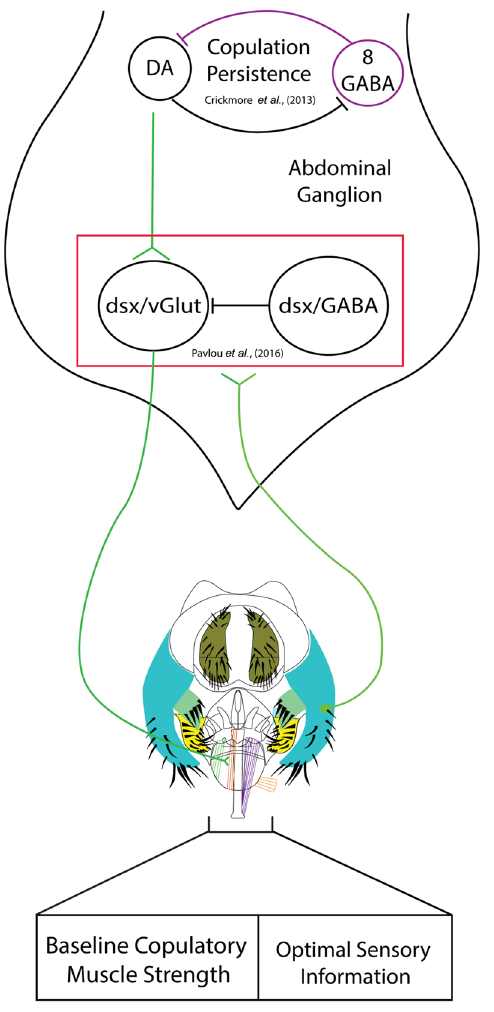
Figure 5. Proposed model of how sensory information from the MSNs is incorporated into the neural circuit that governs copulation persistence. Genital coupling requires the activation of the dsx /vGlut motor neurons that innervate the copulatory muscles. The resulting muscular tension is proportional to the activity level of the dsx/vGlut motor neurons, which are antagonistically regulated by dsx /GABA interneurons. These copulation regulating neurons are functionally connected to the axonal terminals of sensory neurons from the genitalia bristles 40 . We propose that a suboptimal sensory input will reduce the total muscular tension due to less activation of the dsx /vGlut motor neurons or more activation of the dsx /GABA interneurons. Copulation persistence ensures the maintenance of copulation before sperm transfer in the presence of stressful stimulus and is regulated by opposing actions of 8 dsx /GABA and the dopaminergic system in the ventral cord 24 . This persistence requires optimal sensory input from the genitalia